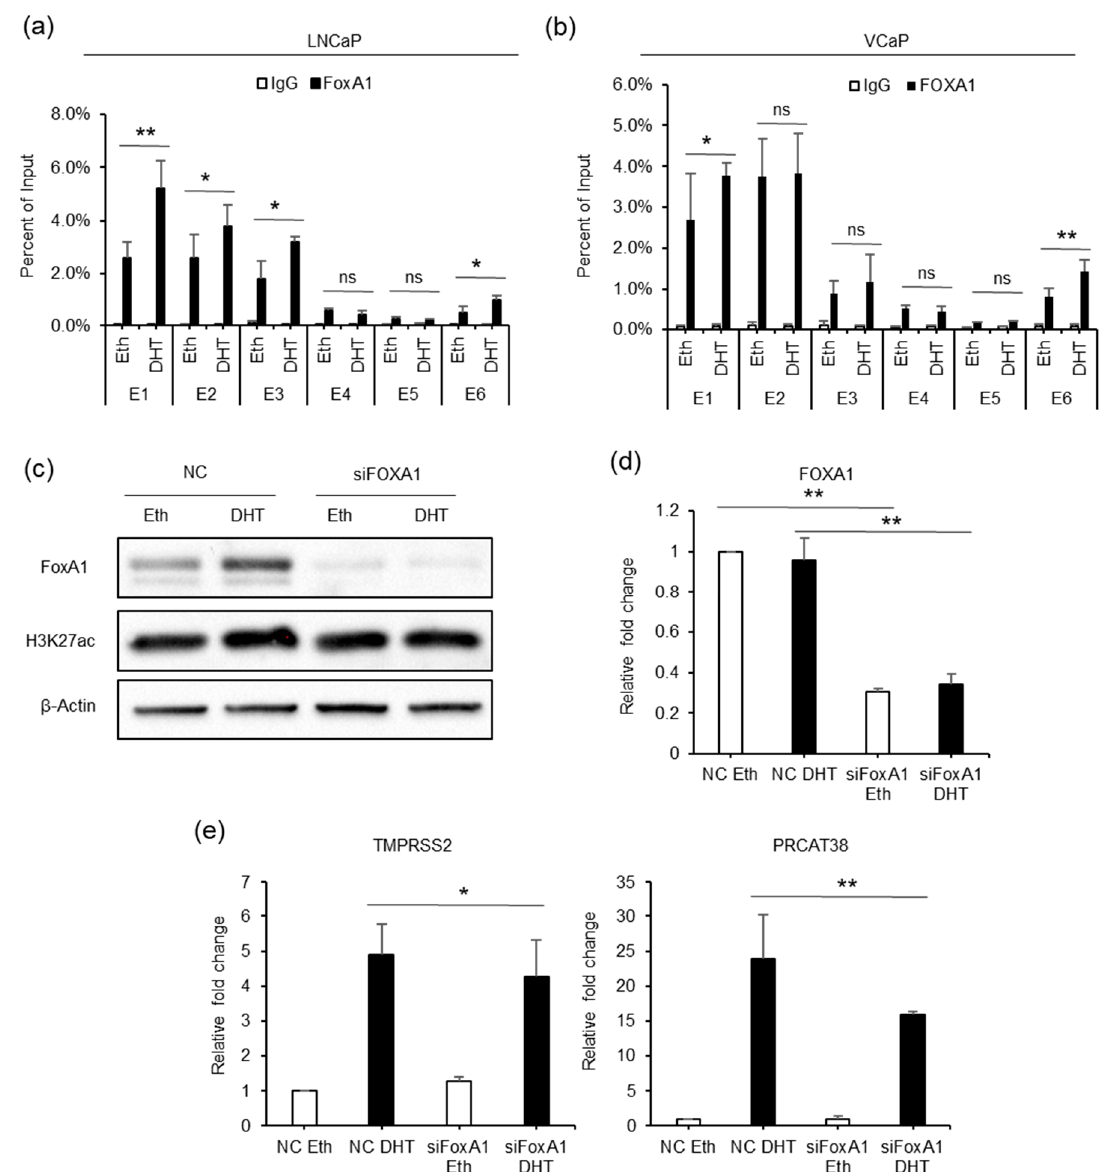
Figure 5. FOXA1 is recruited by the AR to the enhancers and regulates the transcription of TMPRSS2 and PRCAT38 . ( a , b ) ChIP-qPCR before and after DHT treatment showing FOXA1 enrichment over the enhancer regions in LNCaP and VCaP. ( c ) Western blot showing the protein level of FOXA1 and H3K27ac after FOXA1 knockdown with or without DHT treatment. ( d – e ) qPCR showing the down-regulation of FOXA1 , TMPRSS2 and PRCAT38 after FOXA1 knockdown with or without DHT treatment. Data are shown as mean ± SD (n =